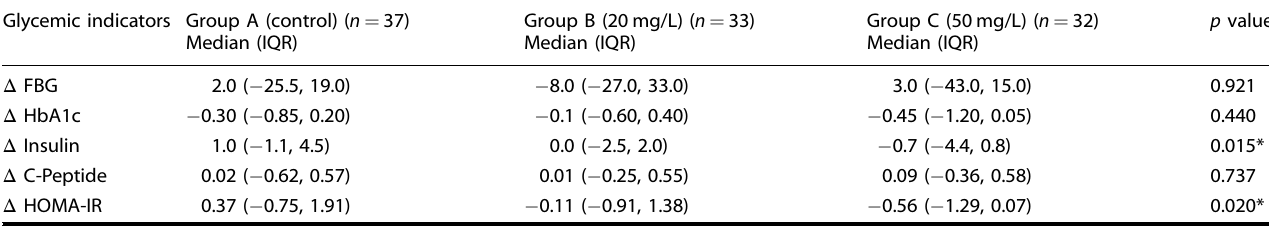
FBG fasting blood glucose, HbA1c glycosylated hemoglobin, HOMA-IR homeostasis model assessment-estimated insulin resistance. *Denote signi fi cant differences in the Kruskal – Wallis test between the delta differences after 3 months between the study groups. ( p < 0.05) compared to the control